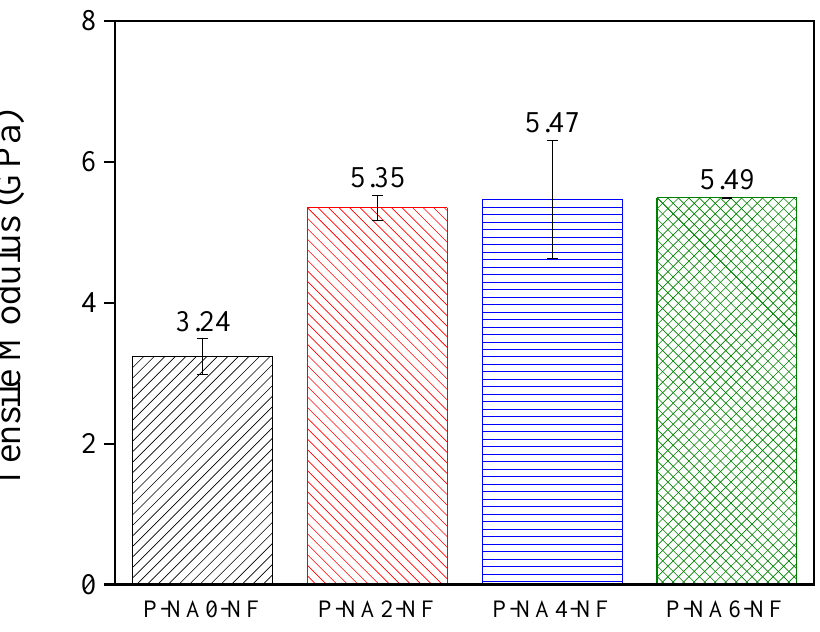
Figure 5. Tensile modulus of the NF-reinforced PLA composites with different NA contents.